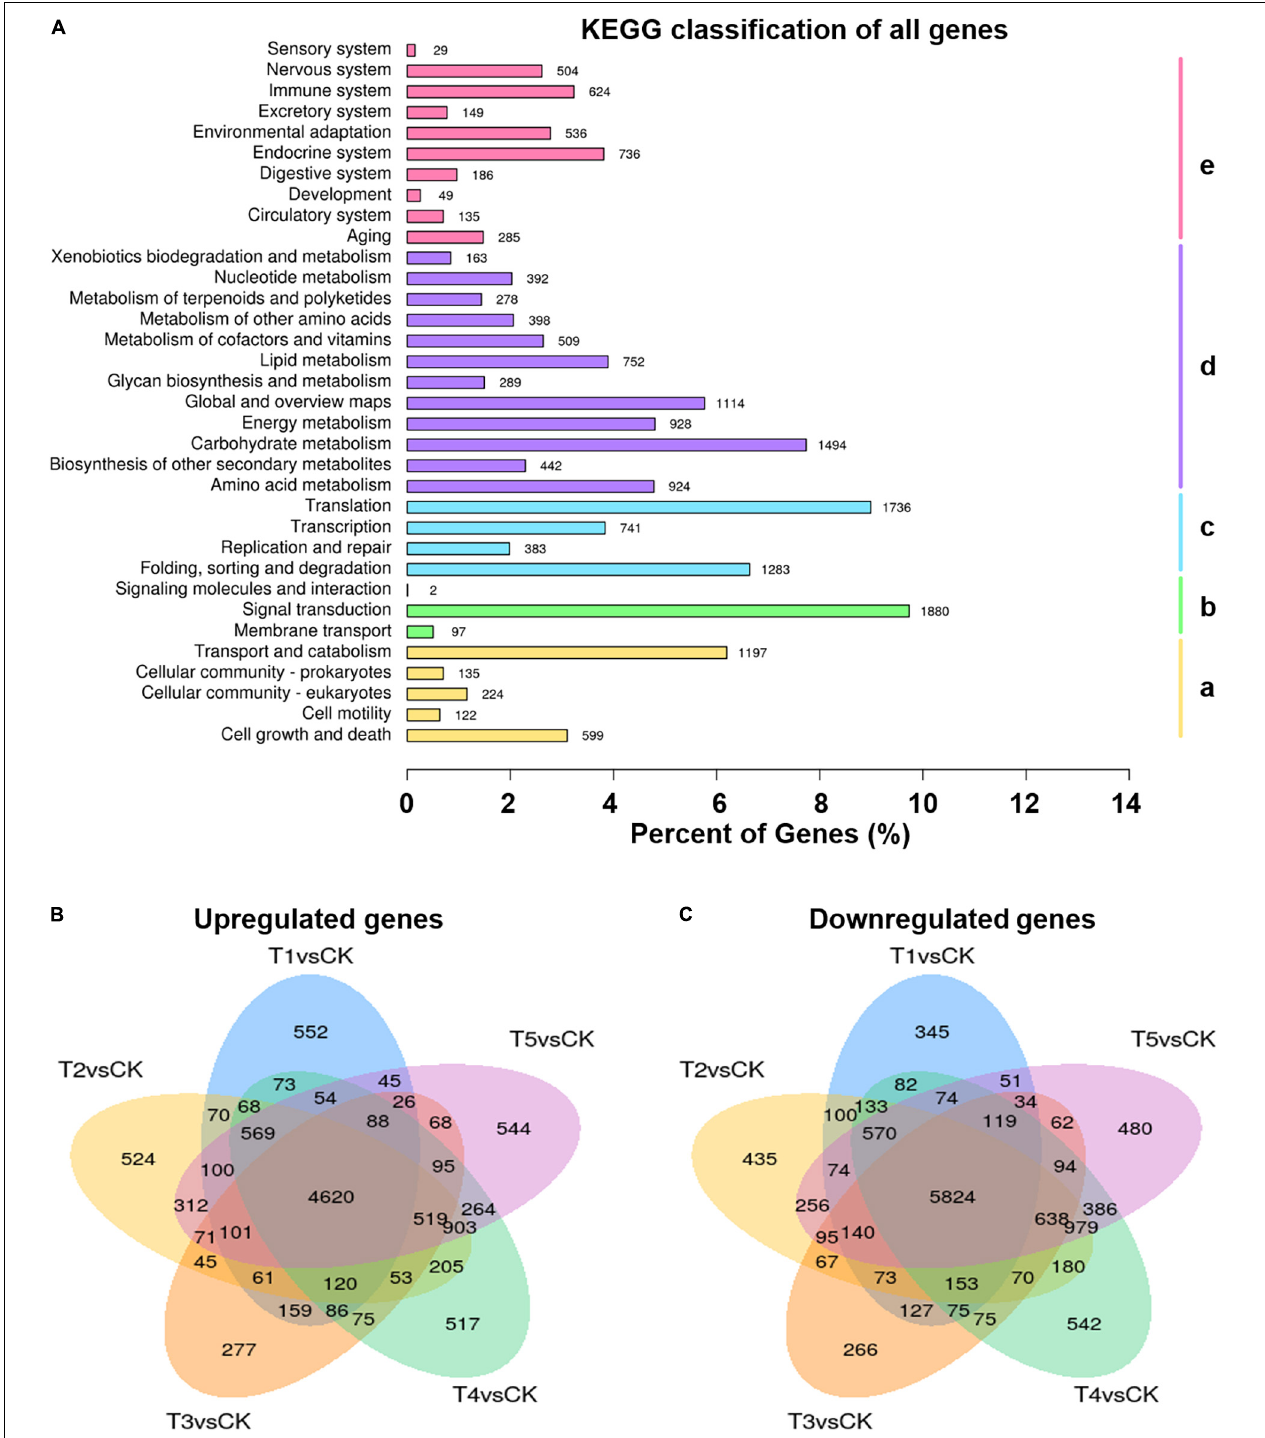
FIGURE 2 | Global transcriptome of plants in response to freezing stress. (A) KEGG classification of all genes annotated. (a) Cellular processes, (b) Environmental information processing, (c) Genetic information processing, (d) Metabolism, (e) Organismal systems. (B,C) Venn diagrams showing the overlap among upregulated (B) and downregulated (C) differentially expressed genes (DEGs) in each of the different duration time freezing treatments and control. T1, –15 ◦ C 0 h under CA condition; T2, –15 ◦ C 2 h under CA condition; T3, –15 ◦ C 6 h under CA condition; T4, –15 ◦ C 12 h under CA condition; and T5, –15 ◦ C 24 h under CA condition. Numbers above each bar and each oval represent gene